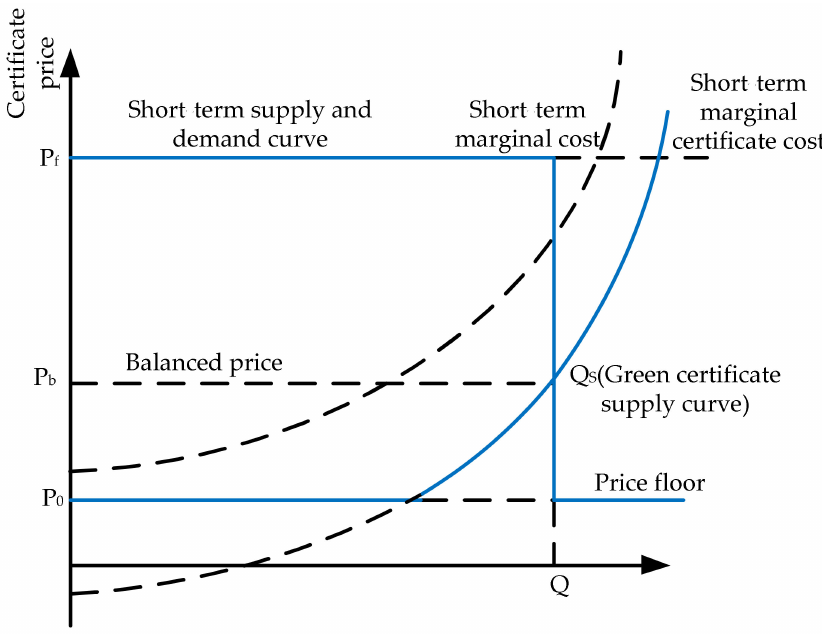
Figure 1. Supply and demand curve of the green certificate exchange